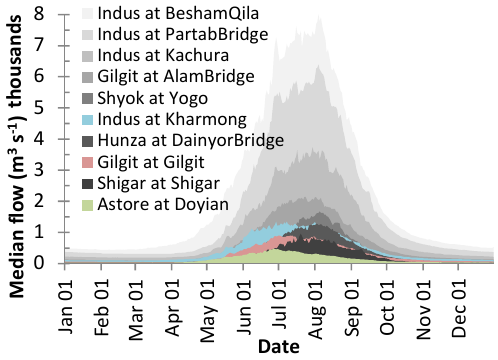
Figure 3. Long-term median hydrograph for 10 gauges separat- ing the sub-basins of the UIB featuring either mainly snow-fed (in color) or glacier-fed (in greyscale) hydrological